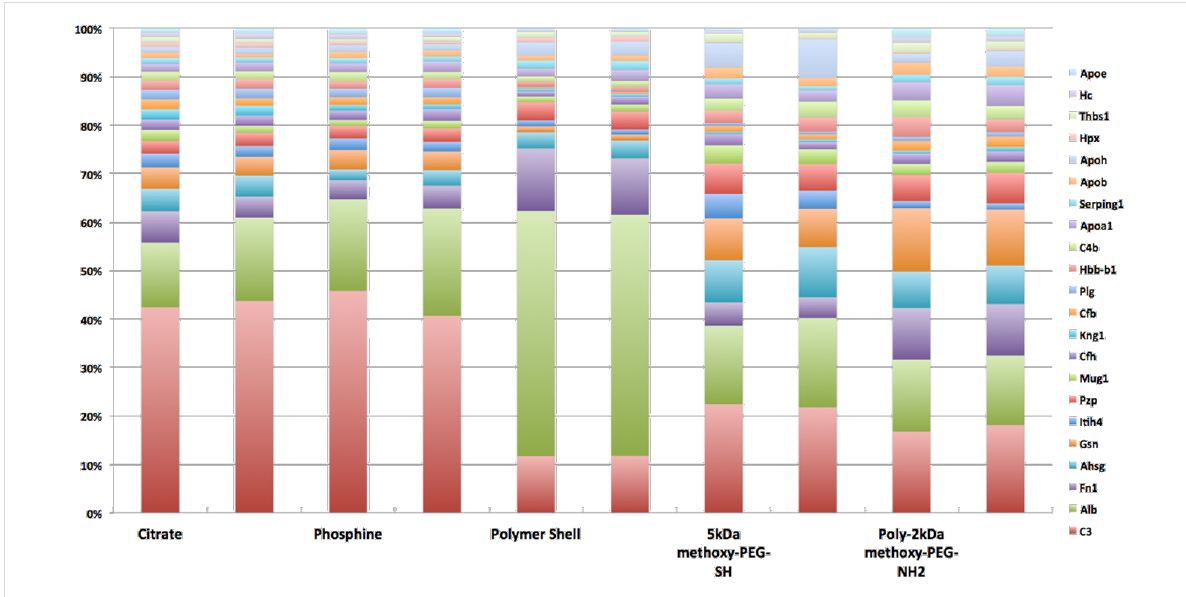
Figure 5: Protein percentages in cumulative stacks of the most abundant proteins bound to either of all five AuNP with different surface modifications in mouse serum after 15 min incubation. The order of the proteins from the bottom to the top of the stack were chosen by the protein with the highest binding percentage to the control AuNP (citrate stabilized) followed by proteins of successively lower binding percentages from bottom to top. Protein abbreviations on the right column from top to bottom: Apoe: apolipoprotein E; Hc: hemolytic complement; Thbs1: thrombospondin 1; HPX: hemopexin; Apoh: apolipoprotein H; Apob: apolipoprotein B; Serping1: serine (or cysteine) peptidase inhibitor; Apoa1: apolipoprotein A1; C4b: complement component 4b; Hbb-b1: hemoglobin, beta adult major chain; Plg: plasminogen; Cfb: complement factor b; Kng1: kininogen 1; Cfh: complement component factor h; Mug1: murinoglobulin 1; Pzp: pregnancy zone protein; Itih4: inter alpha-trypsin inhibitor, heavy chain 4; Gsn: gelsolin; Ahsg: alpha-2-HS-glycoprotein; Fn1: fibronectin 1; Alb: albumin; C3: complement component